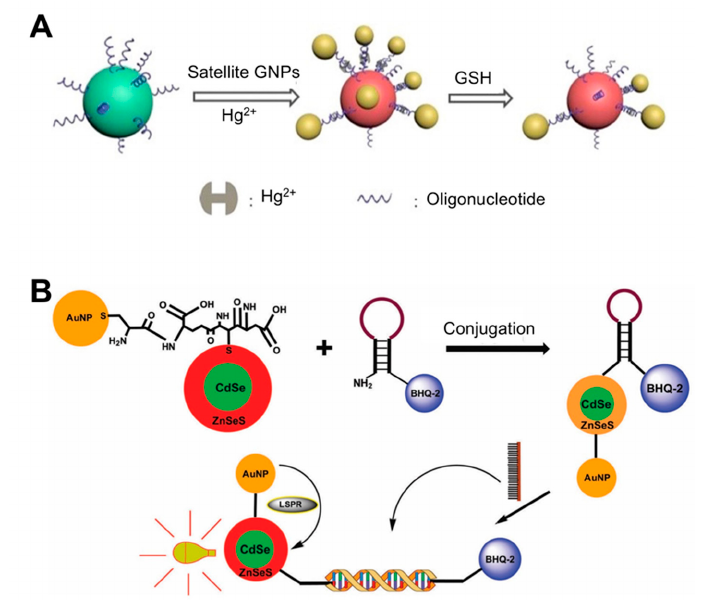
Figure 1. LSPR biosensing strategies based on solution phase-based nanoparticles: ( A ) Glutathione (GSH) detection using Au core-satellite structures containing Hg 2+ . Reproduced with permission from [36]; ( B ) Detection of dengue virus using CdSe/ZnSeS core/alloyed shell quantum dots via band-gap engineering. Reproduced with permission from [7]. GNP, gold nanoparticle.